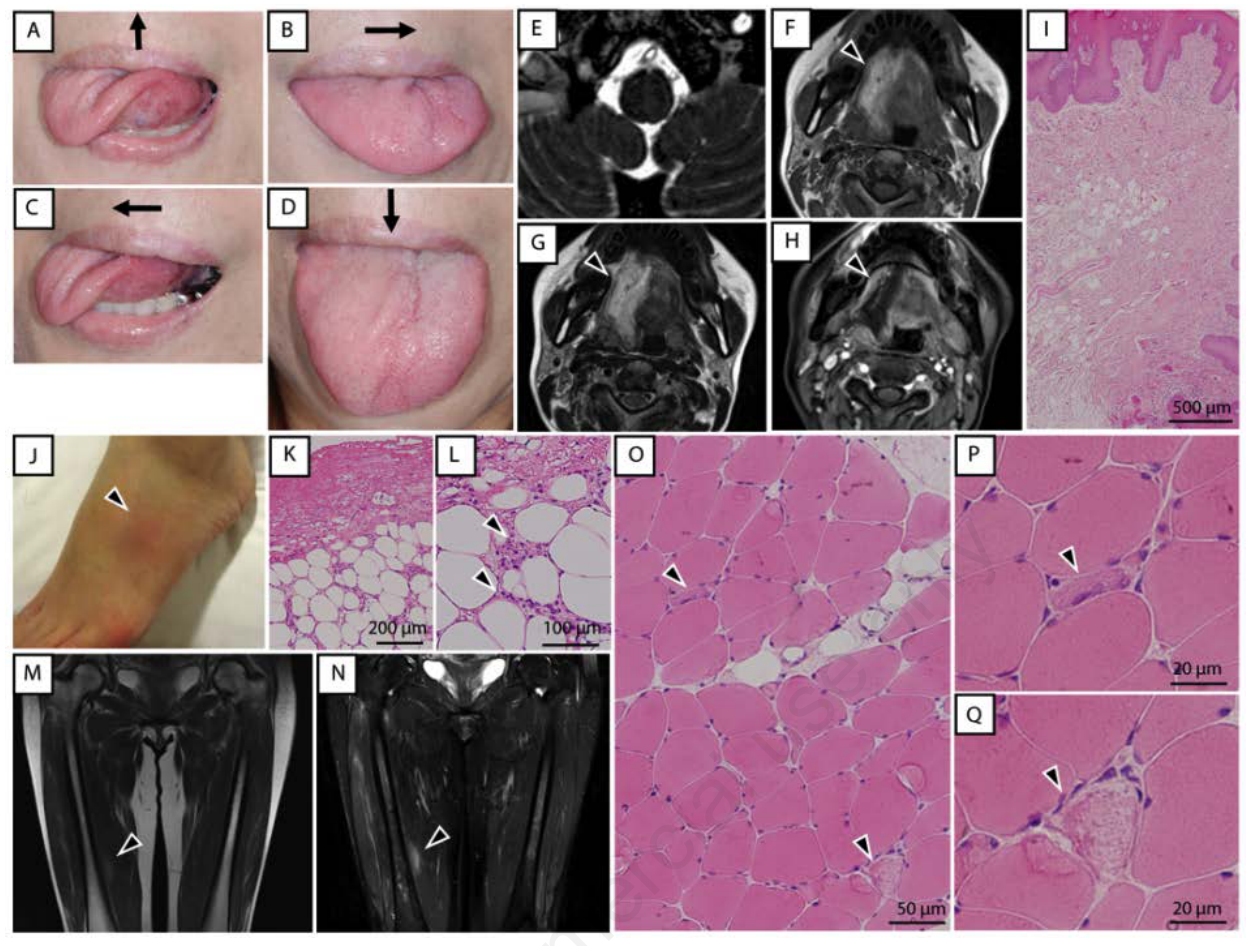
Figure 1. Tongue movements in four directions, upward (A), leftward (B), rightward (C), and downward (D), showing disturbed upward tongue movement (A) and swelling on the right side of the tongue (D). Head MRI (E-H) showing no lesion in medulla oblongata and hypoglossal nerves on T2WI (E), but hyperintensive right side of the tongue on T1WI (F) and T2WI (G) (arrowheads), and a decreased intensity on fat-suppression T1WI without Gd enhancement (H). (I) Right tongue biopsy showing it to be edematous and fibrotic with- out any striated muscles. Erythema on the left foot (J, arrowhead) and its biopsy (K, L), showing lobular panniculitis (L, arrowheads). Thigh MRI on T2WI (M) and fat-suppression T2WI (N) showing hyperintense lesion in the distal portion of the right quadriceps femoralis (arrows). (O-Q) Quadriceps muscle biopsy showing mild variation in fiber size (O) with necrotic fibers (O-Q,